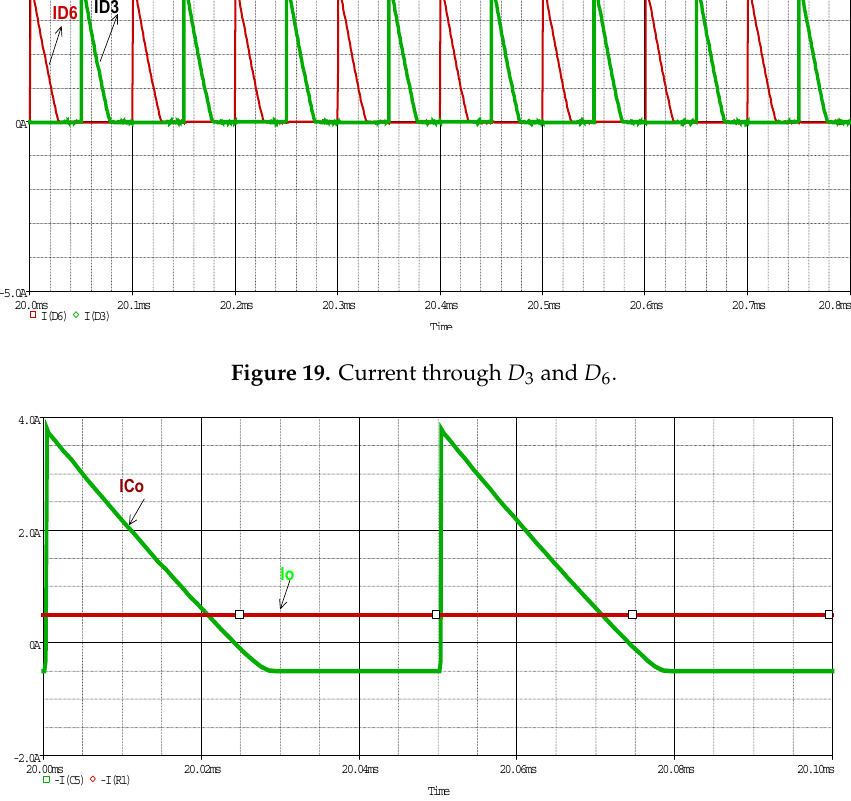
Figure 20. Waveforms for output capacitor current and output load